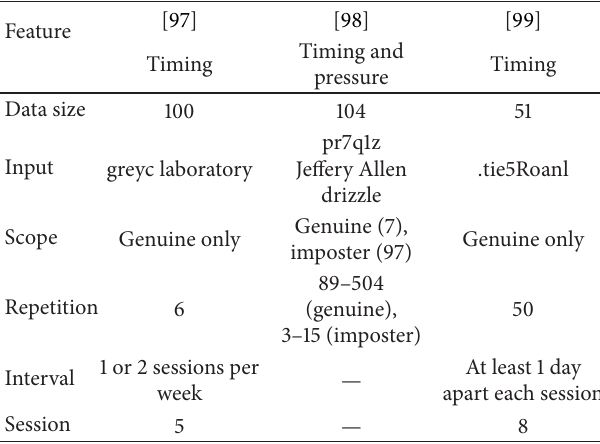
Figure 5: The categorized distribution on the number of input repetition in the keystroke literature. Table 3: Comparison between different public data